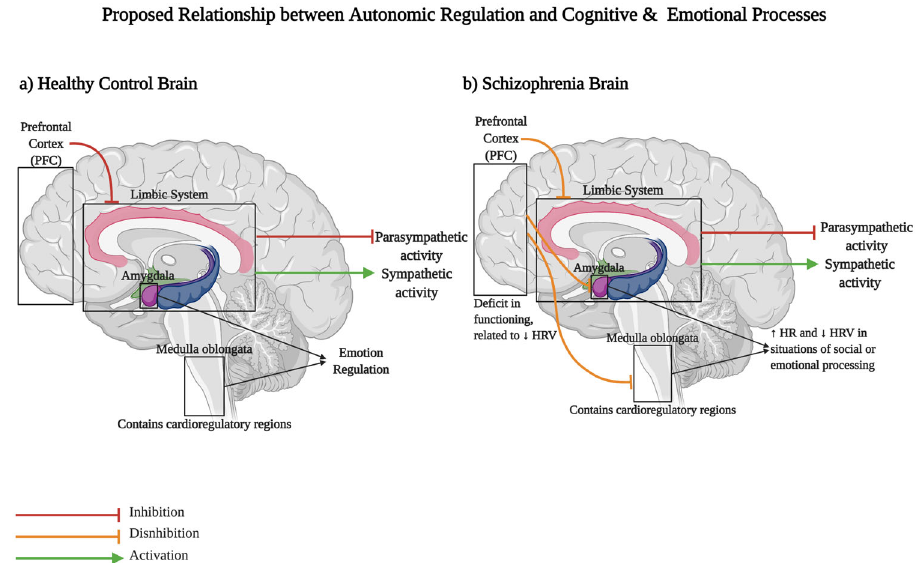
Fig. 3 The Neurovisceral Integration Hypothesis. a Cognitive and emotion processing functions are regulated by brain systems also involved in the regulation of the autonomic nervous system. The Neurovisceral Integration Hypothesis asserts that the prefrontal cortex (PFC) exerts tonic inhibition over limbic brain regions (curved red line) that typically suppress parasympathetic responses (straight red line) and activate sympathetic responses (straight green arrow). b In schizophrenia, de fi cits in the PFC may lead to disinhibition of the amygdala and medullary regions (orange lines) during situations of emotional or social processing. This results in suppression of parasympathetic activity and stimulation of sympathetic activity, thereby causing increased heart rate and decreased heart rate variability. This may potentially be an explanatory mechanism underlying the correlation between decreased HRV and reduced PFC